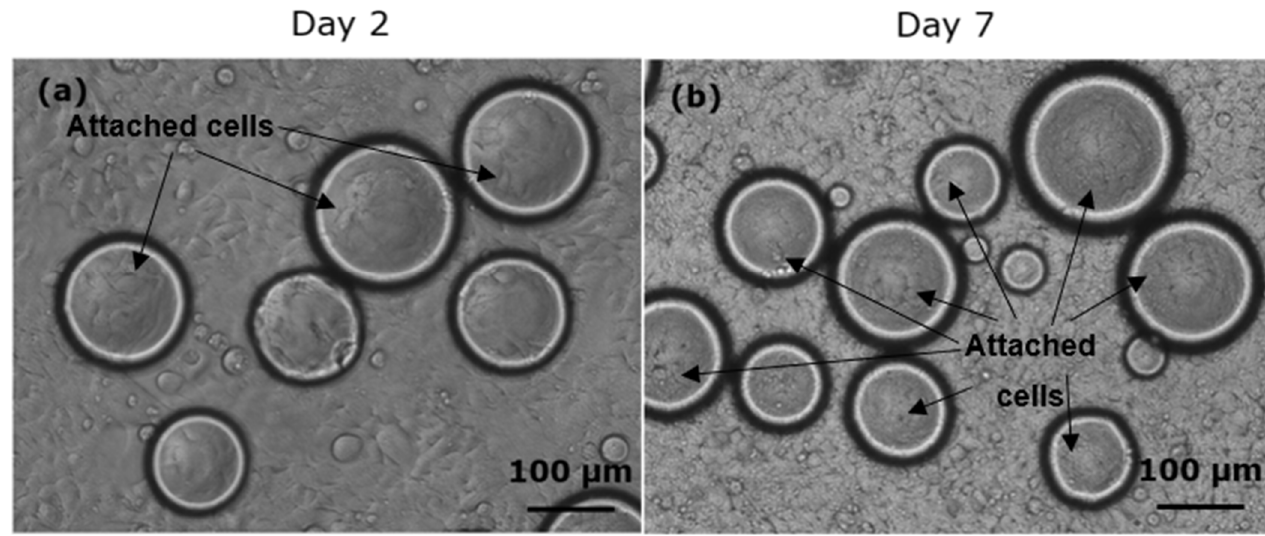
Figure 12. Optical micrographs of HEK cell growth on polyNIPAm microspheres synthesized using redox initiators and CTAB surfactant on ( a ) Day 2 and ( b ) Day 7 of the culturing process.